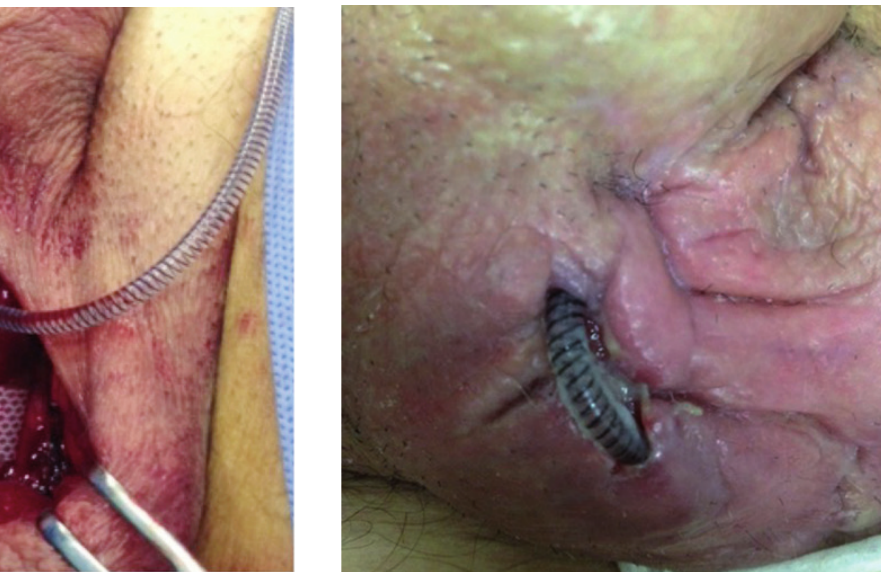
Figure 4 - skin extrusion of the As tube connecting the control pump to the regulator